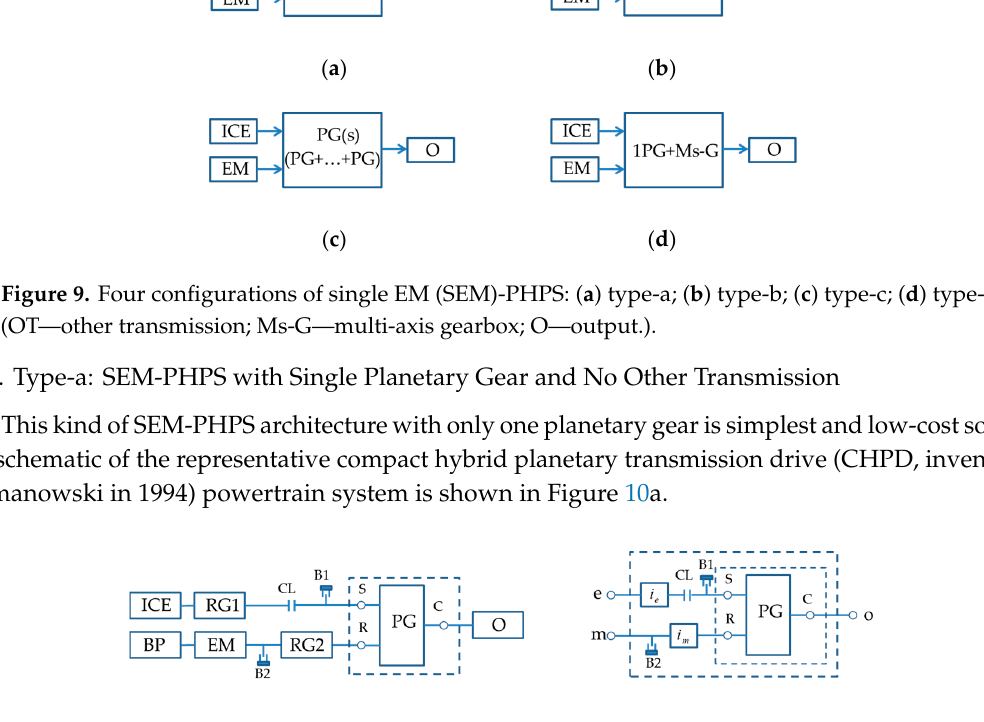
Figure 9. Four configurations of single EM (SEM)-PHPS: ( a ) type-a; ( b ) type-b; ( c ) type-c; ( d ) type-d. (OT—other transmission; Ms-G—multi-axis gearbox; O—output.).